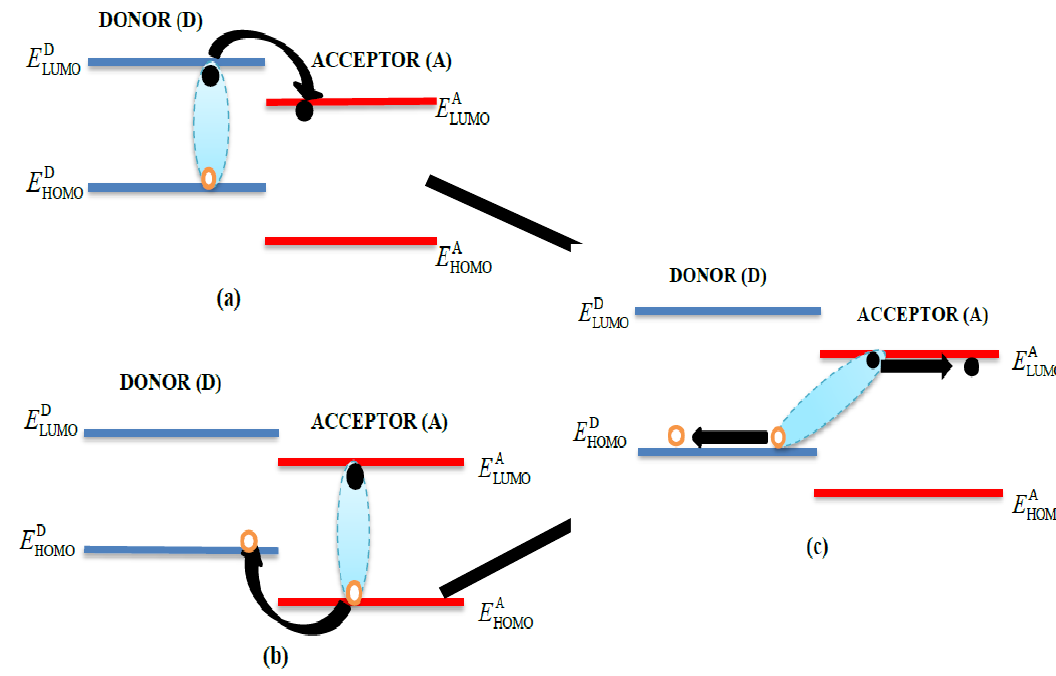
Figure 1. Schematic representations of ( a ) the photoexcitation of the donor and the transfer of an electron to the acceptor at the interface; ( b ) the photoexcitation of the acceptor and the transfer of a hole to the donor at the interface; and ( c ) the formation of charge transfer excitons (CT) through both (a,b) processes in bulk heterojunction (BHJ) organic solar cells (OSCs).